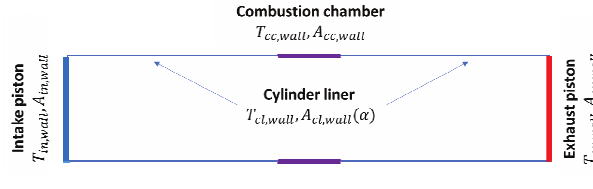
Fig. 6. Boundary conditions for heat-transfer calculations